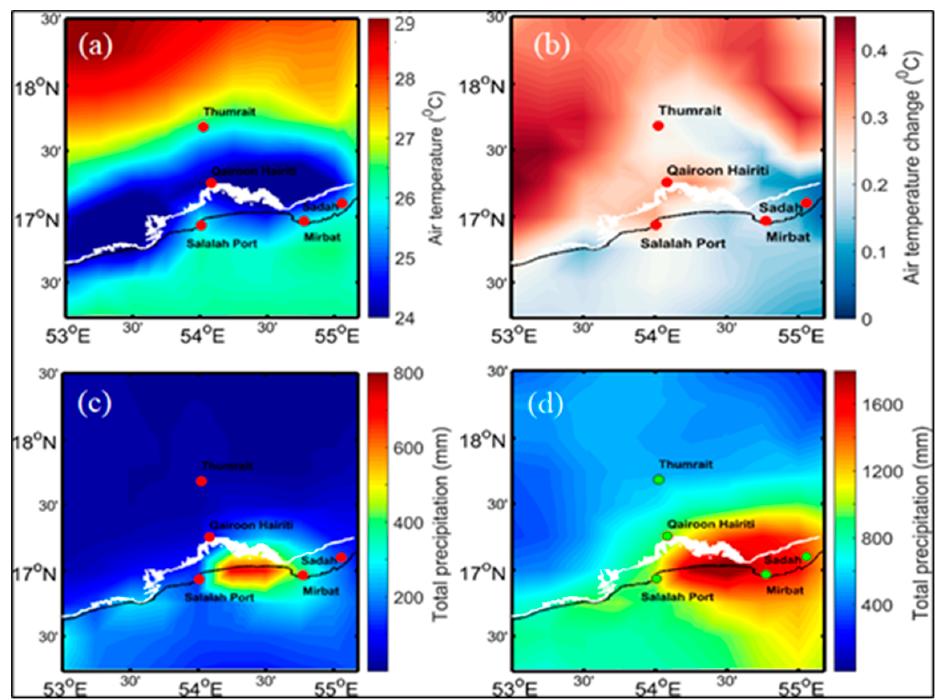
Figure 3. ERA5 model results: ( a ) spatial distribution of annual air temperature ( ◦ C) for the period of 2015–2017, ( b ) change in air temperature between 2015 and 2019, ( c ) total annual rainfall (mm) accumulation for the period 2015–2017, ( d ) total annual rainfall (mm) accumulation for the period 2018–2020. The white-coloured line depicts the mountain peaks’ border.